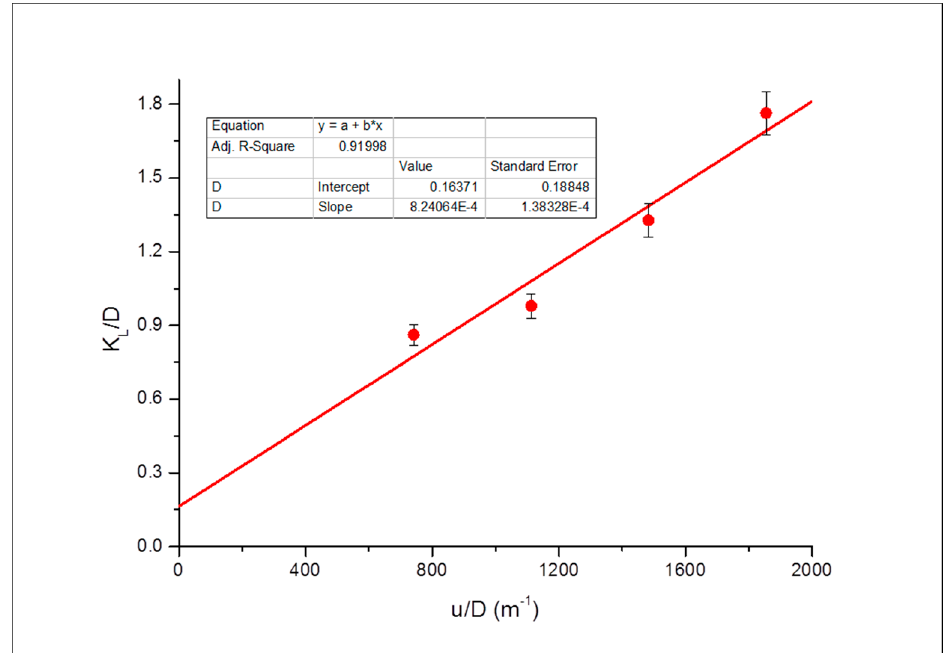
Figure 16. Dispersivity evaluation for Bandera Grey in the vertical orientation.